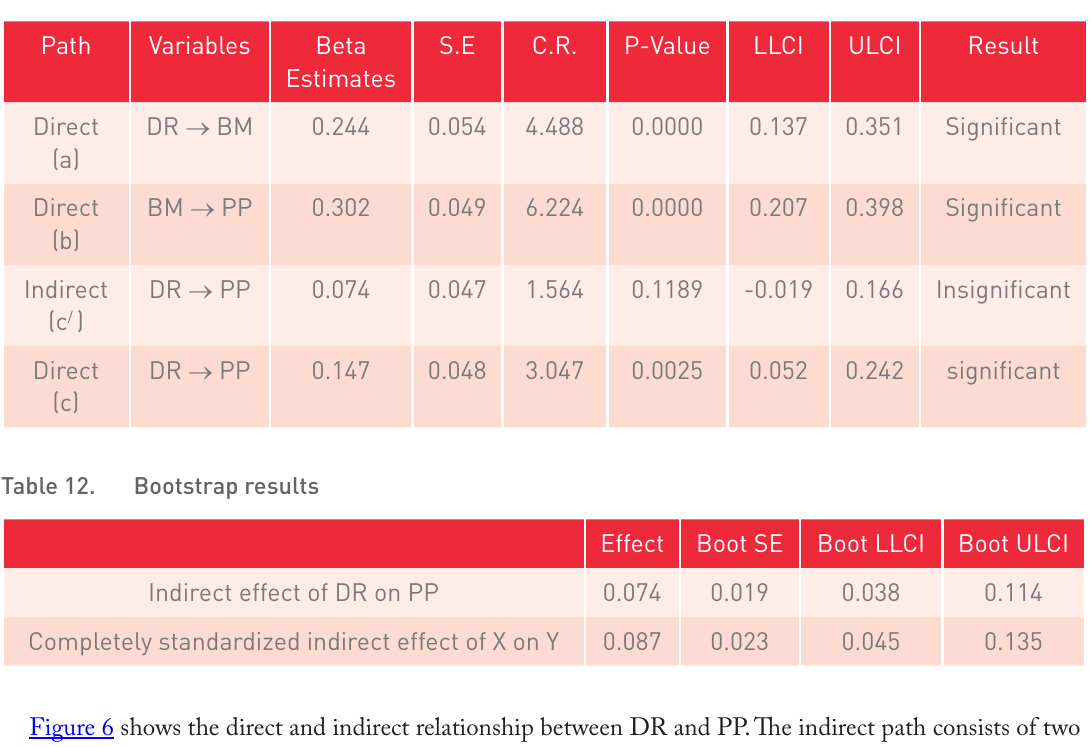
Effect of DR on PP